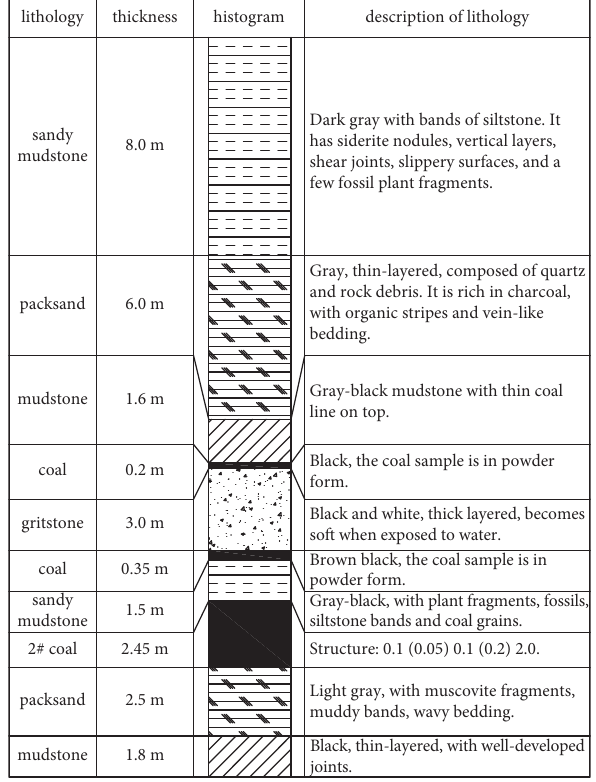
Figure 2: Roof and floor strata of 2# coal